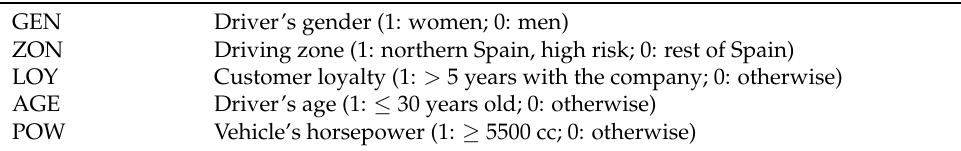
Table 1. Explanatory variables used in the